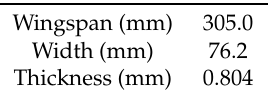
Table 1. Plate wing geometry.